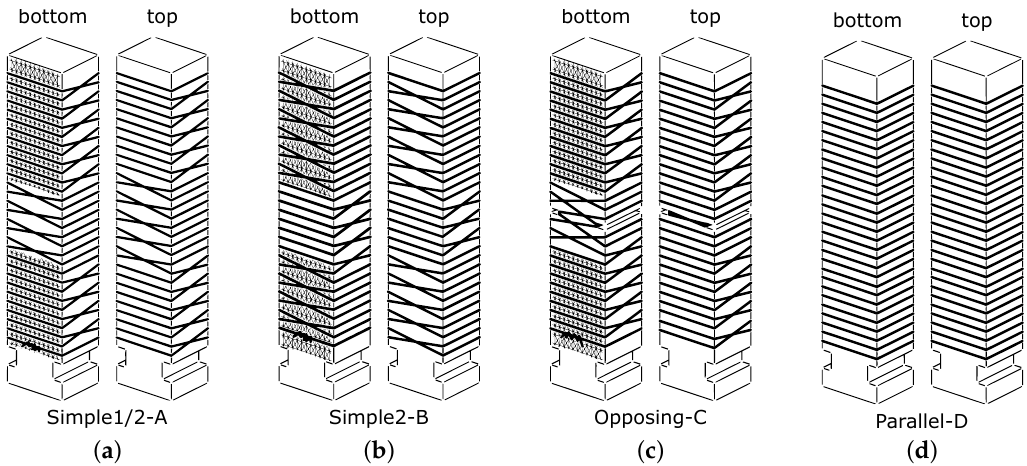
Figure 2. The four different reinforcement layouts used in the fabricated prototypes. ( a ) A, two-directional thread winding, crossing itself on the bottom and top in the middle and on the sides otherwise; ( b ) B, two-directional winding, crossing in the opposite manner from A; ( c ) C, two-directional winding, crossing itself mainly on the bottom and once on the top in the middle; ( d ) D, single loops. A, B, and C had a strain-limiting layer under them, excluded from middle, while D had only the radial reinforcement